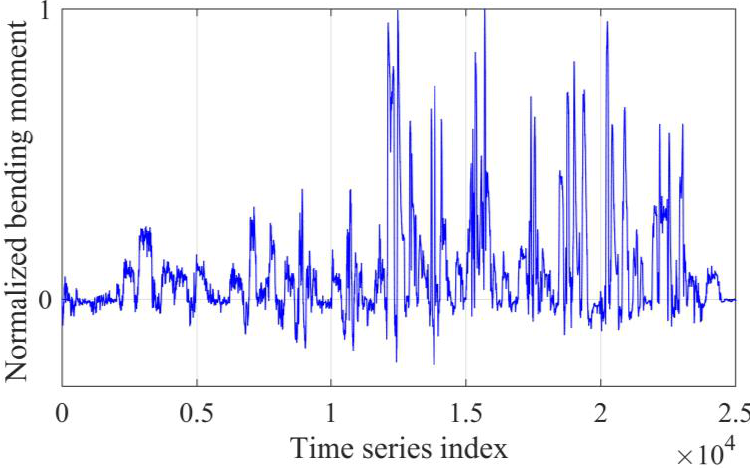
Figure 2. Demonstration of measured bending moment series of aircraft wing during flight.